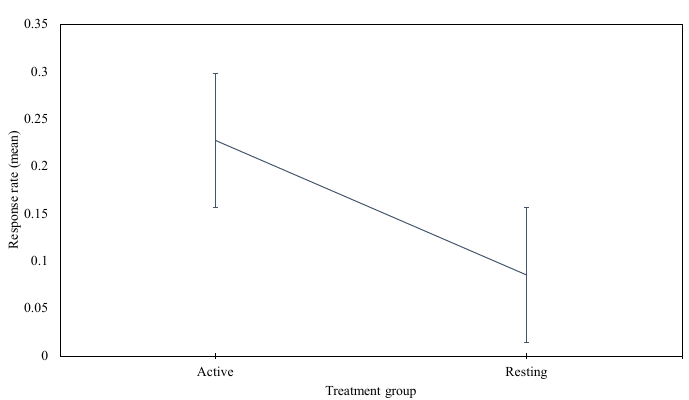
Figure 3. Comparison of response rates in treatment groups for whole study period.